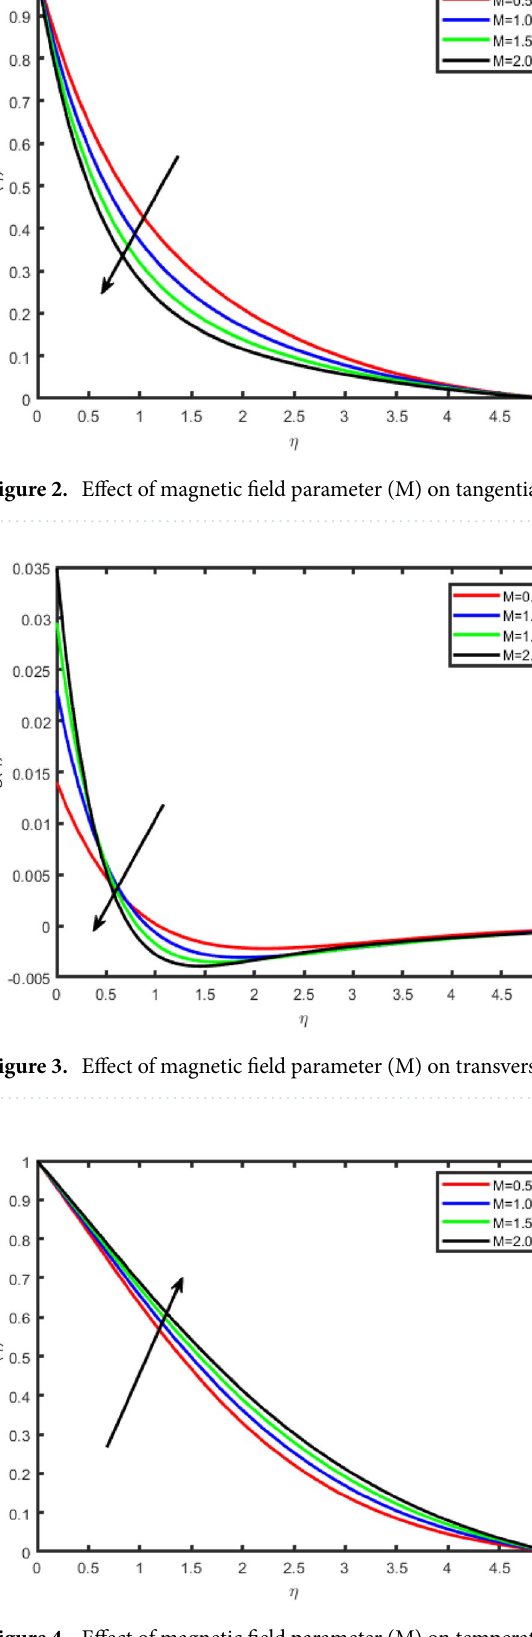
Figure 4. Effect of magnetic field parameter (M) on temperature